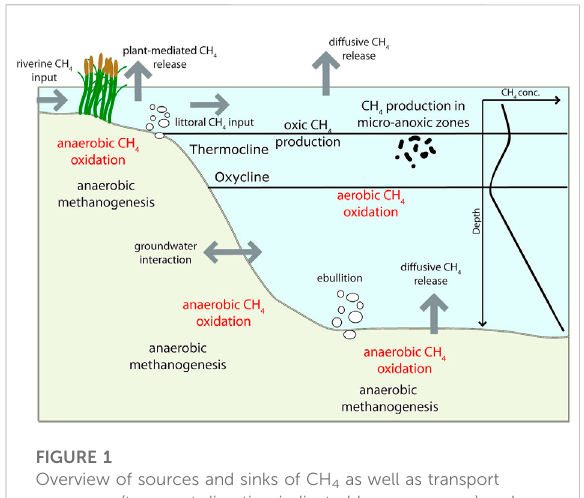
FIGURE 1 Overview of sources and sinks of CH 4 as well as transport processes (transport direction indicated by grey arrows) and a typical concentration pro fi le of CH 4 in the lacustrine environment during thermal strati fi cation. Modi fi ed after Tang et al.